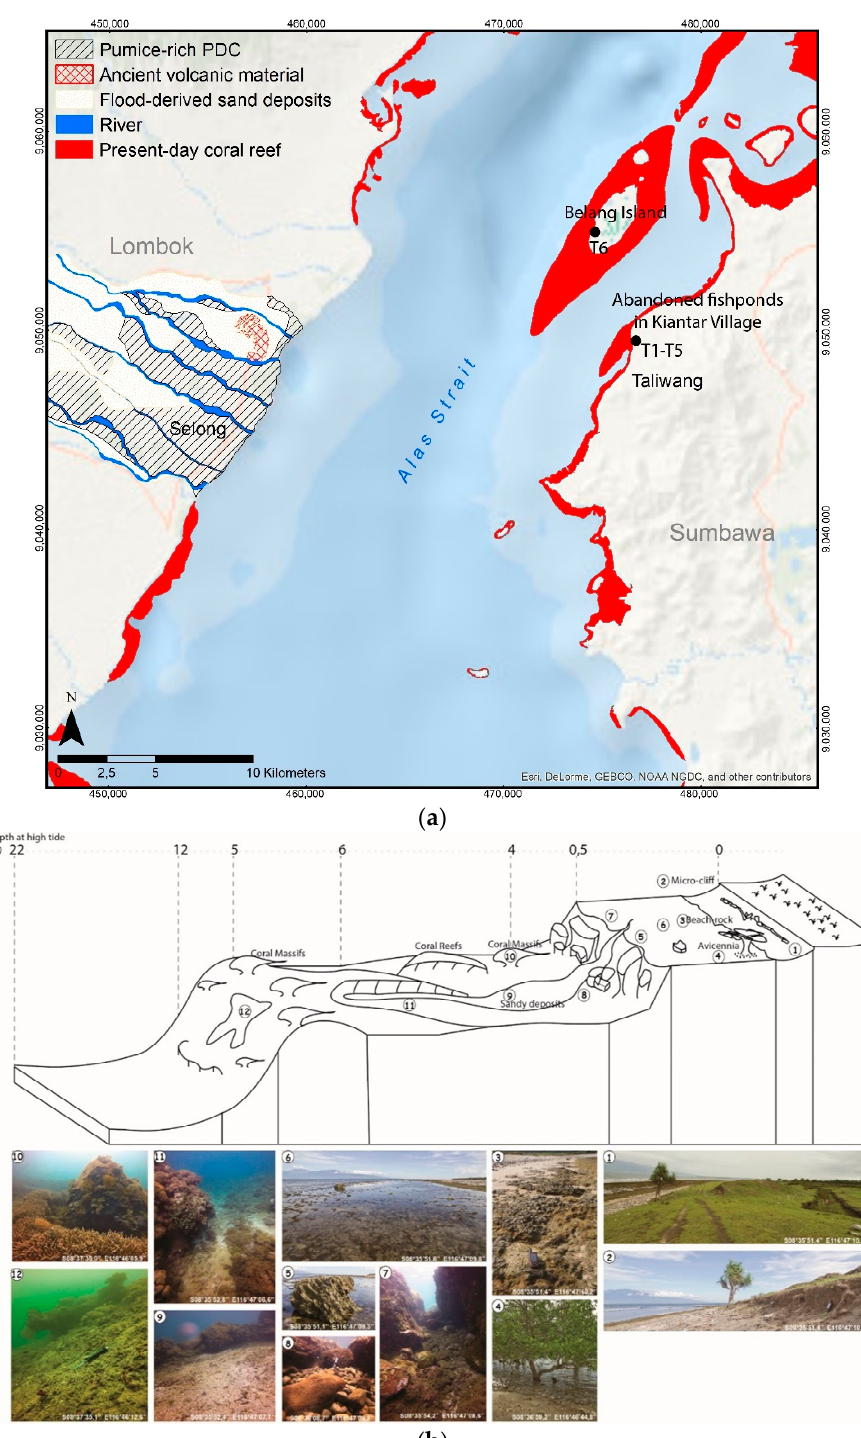
Figure 3. ( a ) Spatial distribution of coral reefs along the Alas Strait in the present-day (modified from [11] and [34]); and ( b ) General landscapes on the western coast of Sumbawa (courtesy of A. Landa,